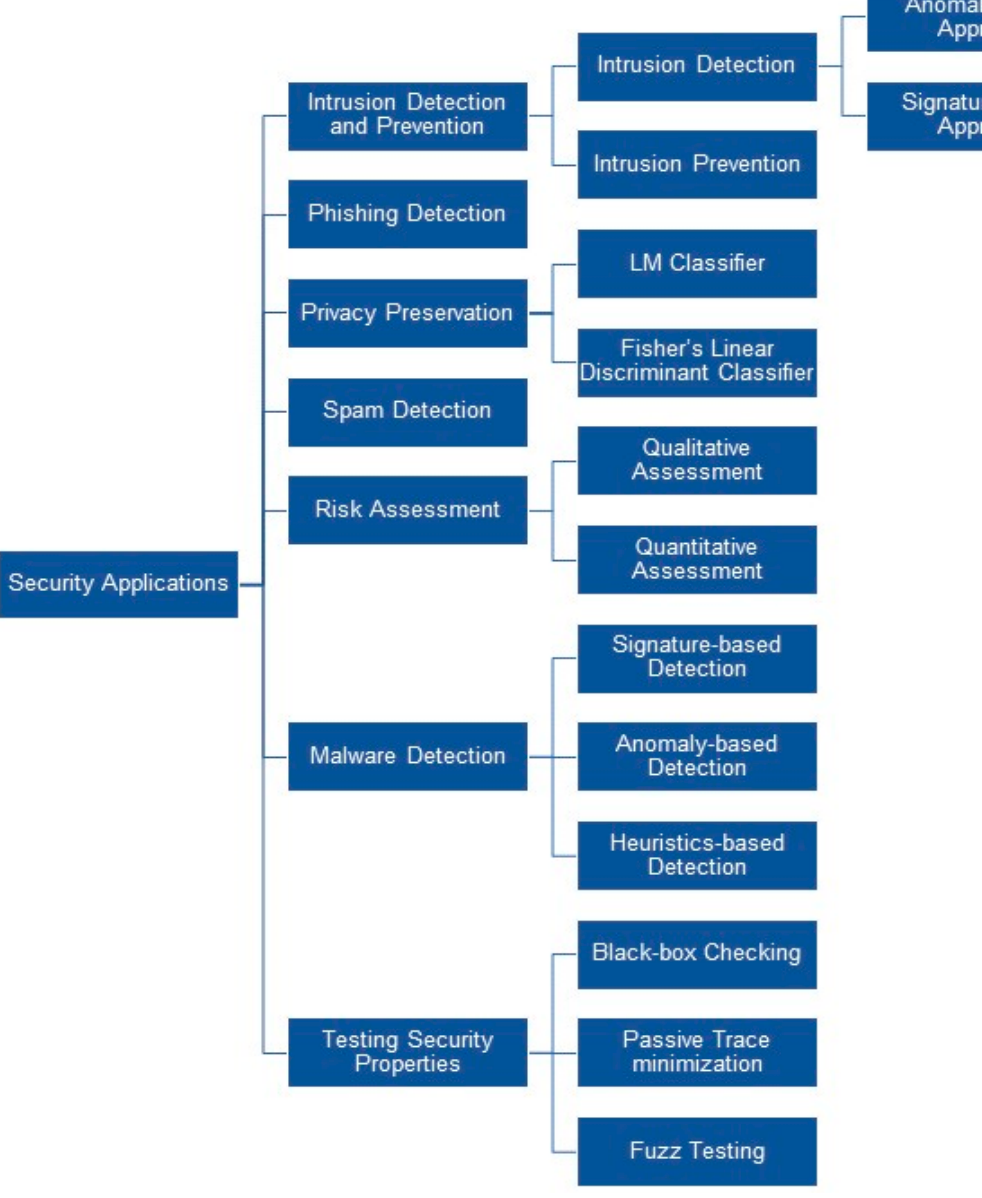
Figure 2. Taxonomy of Security Applications.